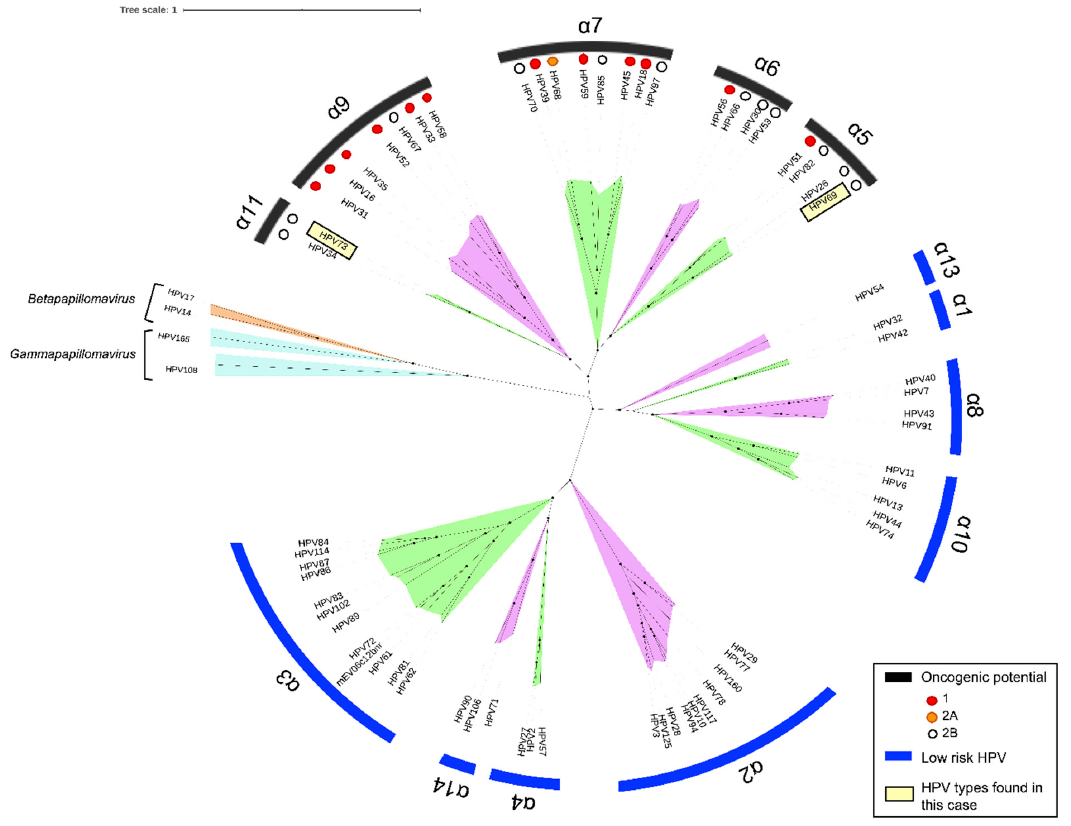
Figure 4. Alphapapillomavirus phylogenetic reconstruction based on whole genome sequences